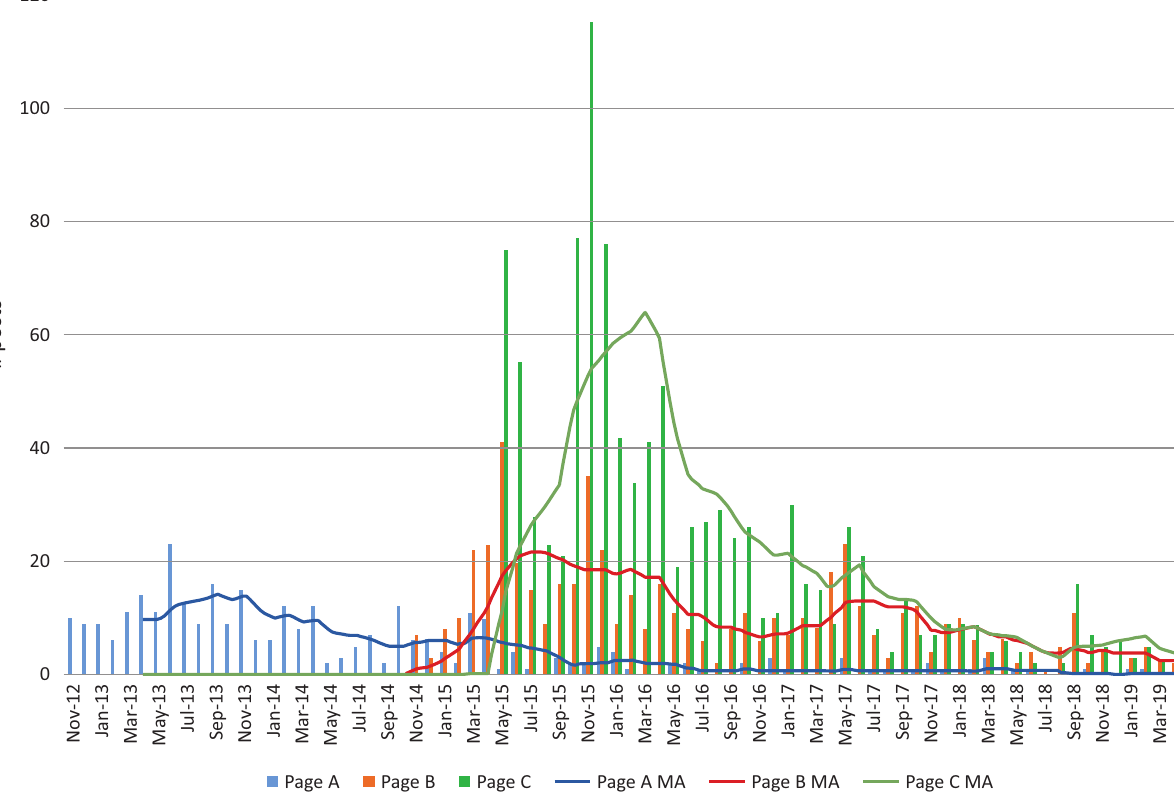
Figure 1. Frequency of posts from November 2012 to May 2019 with corresponding six month simple moving averages. Note: Our count was last updated on December 13,